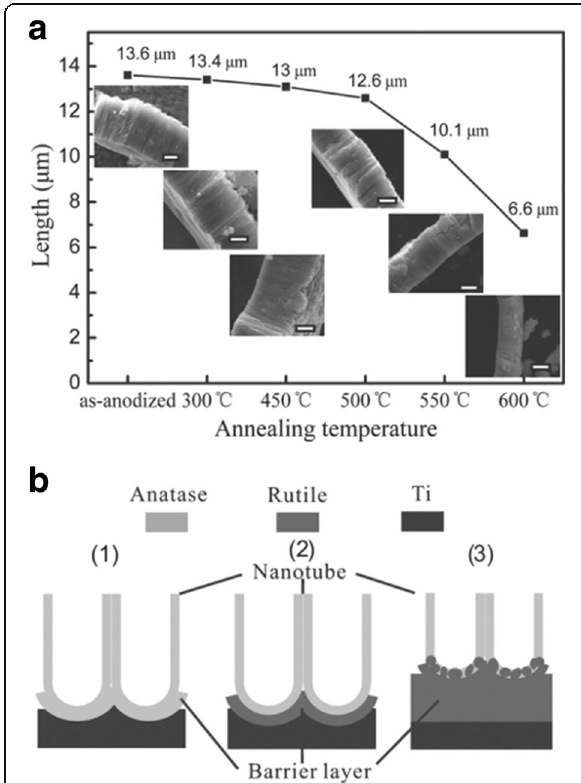
Fig. 9 Evolution of titania nanotube arrays at different calcination temperatures. The electrolyte was ethylene glycol containing 0.3 wt% ammonium fluoride and 5 vol% distilled water. a The decrease in the thickness of titania nanotube arrays at different annealing temperature from 300 to 600 °C. The insets are corresponding SEM images and the scale bar is 5 μ m. b The schematic of crystallization process of anodic titania nanotubes annealed at (1) 450 °C, (2) 500 °C, and (3) 600 °C in air. Reproduced from ref.